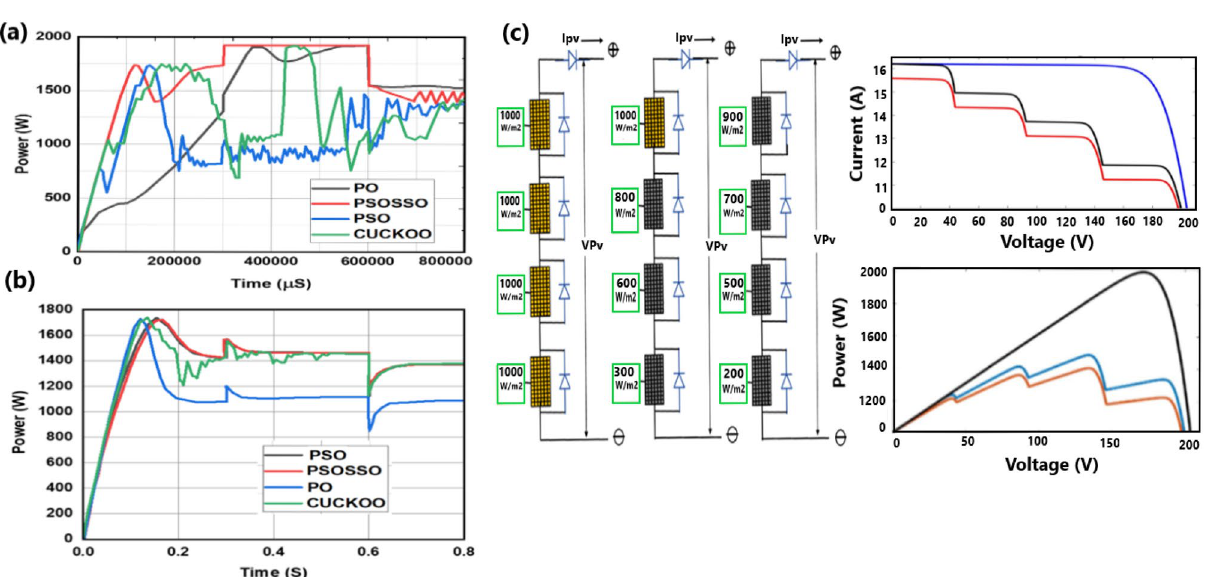
Figure 16. Tracking mechanism of PSOSSO under complex partial shading conditions (CPSCs) condition with linear load (resistor) ( b ) and nonlinear load (battery) ( a ) connected. The partial shading Conditions (4SP3) PV module connection and the P–V, I–V curves ( c